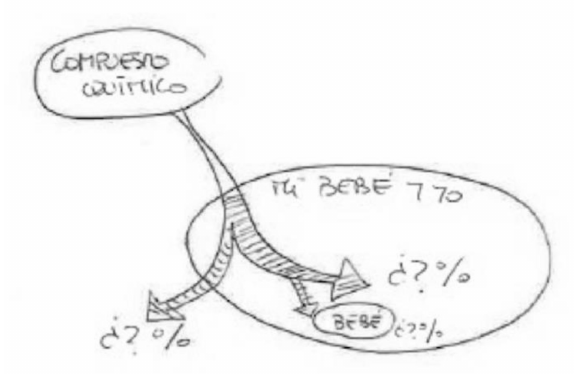
Figure 13. Breastfeeding, university education,